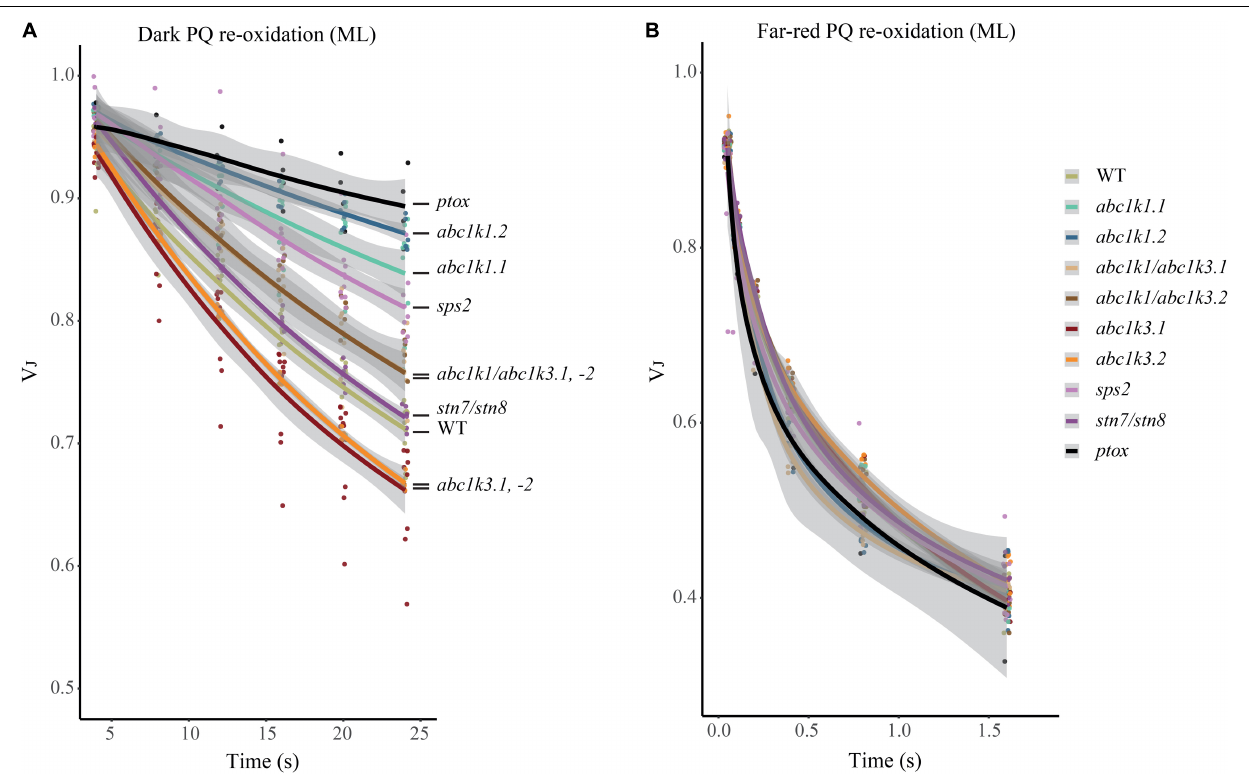
FIGURE 6 | Mutations of ABC1K1 and ABC1K3 influence the dark re-oxidation kinetic of the photoactive plastoquinone. The relative fluorescence after 3 ms (V J ) is plotted over the time from the previous saturating pulse. The sample was incubated in dark (A) or with far-red light (B) . Kinetics of the re-oxidation are shown by interpolation of the data points with a logarithmic curve with the deviation of the model in gray (R-Studio) for wild type (WT) abc1k1.1, -2, abc1k3.1, -2, and abc1k1/abc1k3.1, -2, sps2, stn7/stn8, ptox plants grown under moderate light (ML). These measures were performed with Handy-PEA (Hansatech Instruments) on detached leaves incubated for 10 min in